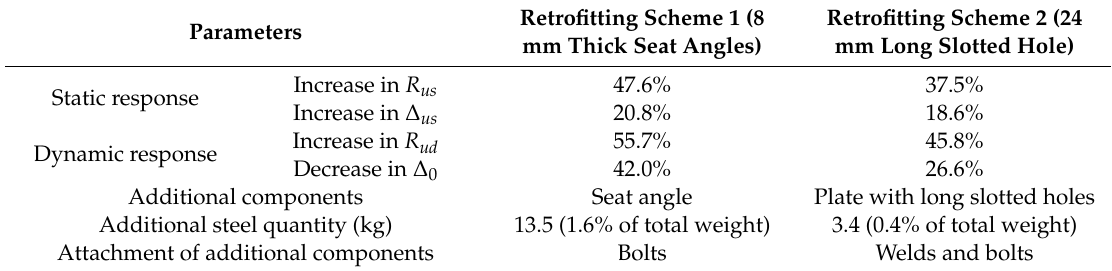
Table 1. Comparisons between retrofit strategy 1 and retrofit strategy 2.